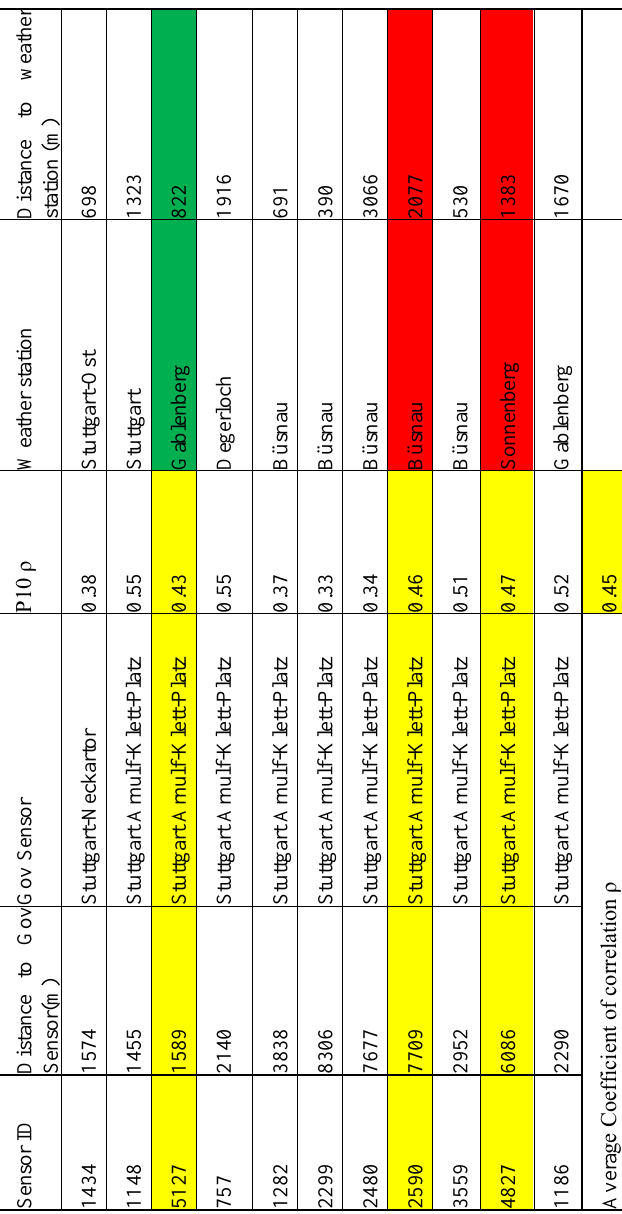
Table 1. Comparison of Sensors with 3380